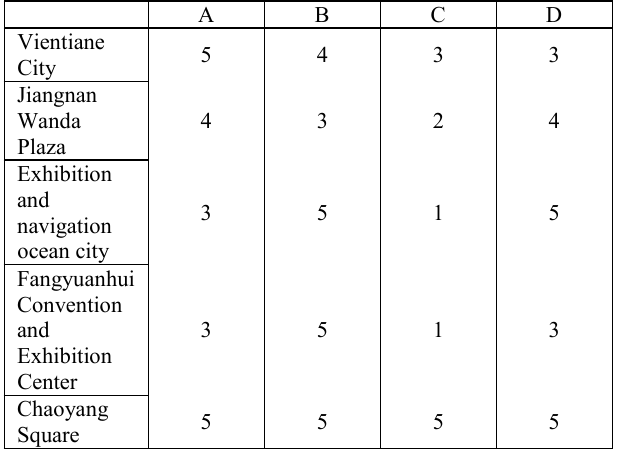
Table 2. Partial Mall Sample Data